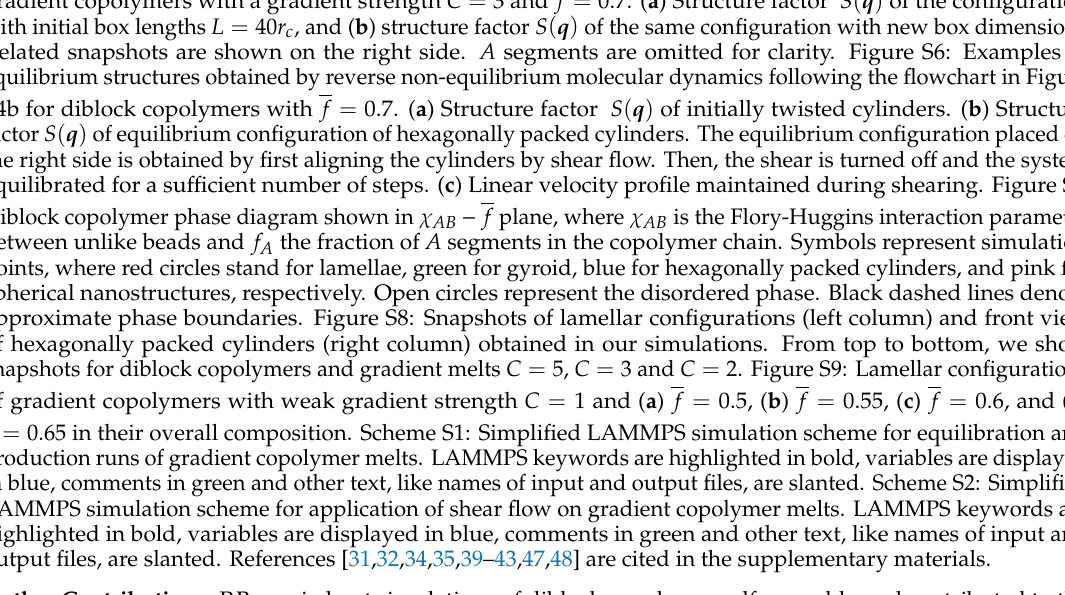
Figure S1: ( a ) Average composition of generated sequences γ ( i ) compared with target average composition profile f ( i ) ; ( b ) block size distribution φ b ( i ) and ( c ) compositional polydispersity σ ( i ) for gradient copolymer melts with tan-h profile and C = 5. All variables are functions of the position of segment i in the chain. Melts with di ff erent chain length N are compared. Figure S2: ( a ) Average composition of generated sequences γ ( i ) compared with the target average composition profile f ( i ) ; ( b ) block size distribution φ b ( i ) and ( c ) compositional polydispersity σ ( i ) for gradient copolymer melts with tanh profile and C = 1. All variables are functions of the position of segment i in the chain. Melts with di ff erent chain length N are compared. Figure S3: Simulation flowchart where symbol a AB represents the repulsion between unlike species, P OP the order parameter and S ( q ) the structure factor. Inset shows evolution of the order parameter and its first derivative as a function of a AB . Part of the flowchart related to initial and production runs in LAMMPS is also shown in Scheme S1. Figure S4: ( a ) Flowchart to find the equilibrium structure by means of structure factor S ( q ) and scaling of the simulation box length L box . Symbol a AB represents the repulsion between unlike species and P OP the order parameter. ( b ) Flowchart related to the application of the reverse non-equilibrium molecular dynamics method. The symbol γ stands for shear rate, and v x and z stand for the x component of velocity v relative to z direction, respectively. Part of the flowchart related to the application of shear in LAMMPS is also shown in Scheme S2. Figure S5: Examples of equilibrium structures obtained by means of structure factor S ( q ) and unit cell box size L eq , applying the flowchart in Figure S4a for gradient copolymers with a gradient strength C = 3 and f = 0.7. ( a ) Structure factor S ( q ) of the configuration with initial box lengths L = 40 r c , and ( b ) structure factor S ( q ) of the same configuration with new box dimensions. Related snapshots are shown on the right side. A segments are omitted for clarity. Figure S6: Examples of equilibrium structures obtained by reverse non-equilibrium molecular dynamics following the flowchart in Figure S4b for diblock copolymers with f = 0.7. ( a ) Structure factor S ( q ) of initially twisted cylinders. ( b ) Structure factor S ( q ) of equilibrium configuration of hexagonally packed cylinders. The equilibrium configuration placed on the right side is obtained by first aligning the cylinders by shear flow. Then, the shear is turned o ff and the system equilibrated for a su ffi cient number of steps. ( c ) Linear velocity profile maintained during shearing. Figure S7: Diblock copolymer phase diagram shown in χ AB − f plane, where χ AB is the Flory-Huggins interaction parameter between unlike beads and f A the fraction of A segments in the copolymer chain. Symbols represent simulation points, where red circles stand for lamellae, green for gyroid, blue for hexagonally packed cylinders, and pink for spherical nanostructures, respectively. Open circles represent the disordered phase. Black dashed lines denote approximate phase boundaries. Figure S8: Snapshots of lamellar configurations (left column) and front view of hexagonally packed cylinders (right column) obtained in our simulations. From top to bottom, we show snapshots for diblock copolymers and gradient melts C = 5, C = 3 and C = 2. Figure S9: Lamellar configurations of gradient copolymers with weak gradient strength C = 1 and ( a ) f = 0.5, ( b ) f = 0.55, ( c ) f = 0.6, and ( d ) f = 0.65 in their overall composition. Scheme S1: Simplified LAMMPS simulation scheme for equilibration and production runs of gradient copolymer melts. LAMMPS keywords are highlighted in bold, variables are displayed in blue, comments in green and other text, like names of input and output files, are slanted. Scheme S2: Simplified LAMMPS simulation scheme for application of shear flow on gradient copolymer melts. LAMMPS keywords are highlighted in bold, variables are displayed in blue, comments in green and other text, like names of input and output files, are slanted. References [31,32,34,35,39–43,47,48] are cited in the supplementary